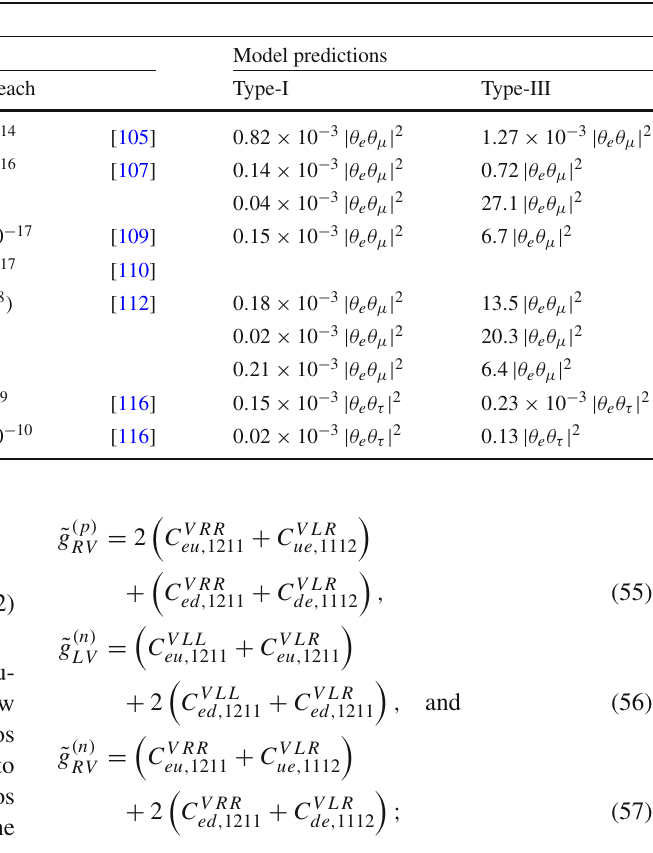
upper (lower) value listed for the future reach of CR( μ − e ; Al) refers to COMET (Mu2e). The model predictions are obtained from matching onto SMEFT at the Seesaw scale μ = M X = 1TeV, running to the electroweak scale μ = m Z , matching onto LEFT and running to